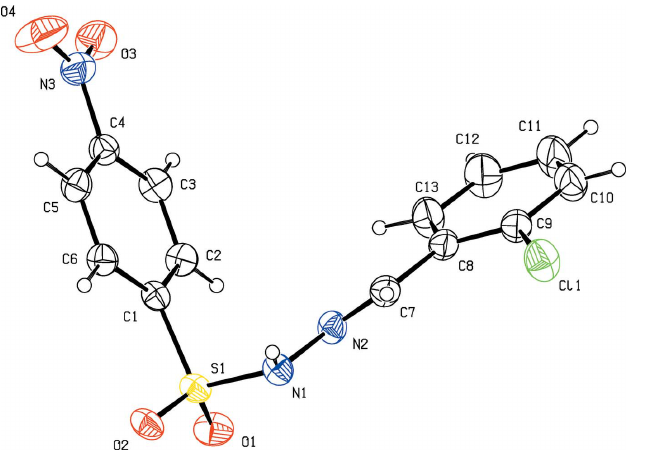
Figure 3 Molecular structure of compound (III), showing the atom labelling and displacement ellipsoids drawn at the 30% probability